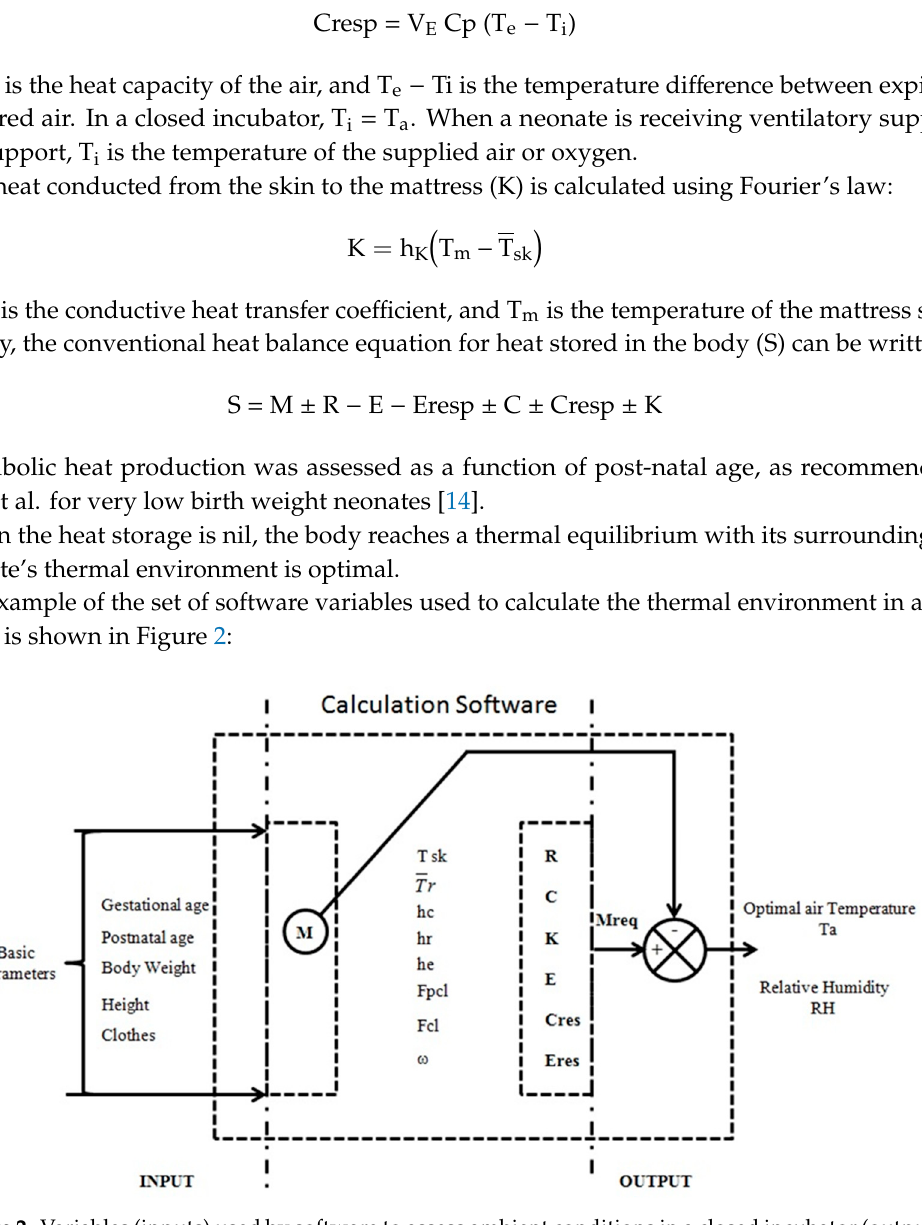
Figure 2. Variables (inputs) used by software to assess ambient conditions in a closed incubator (output), on the basis of the mathematical equations given above.